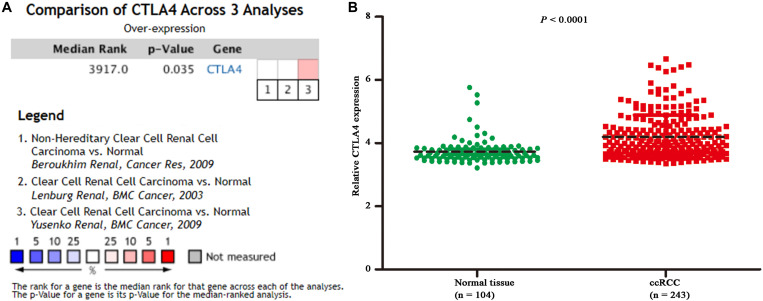
Oncomine and MMD database analyses. (A) Comparison of CTLA4 mRNA expression across 3 analyses of ccRCC based on Oncomine database. (B) Comparison of CTLA4 mRNA expression across 104 normal tissues and 243 cancerous tissues based on MMD database (P < 0.0001).